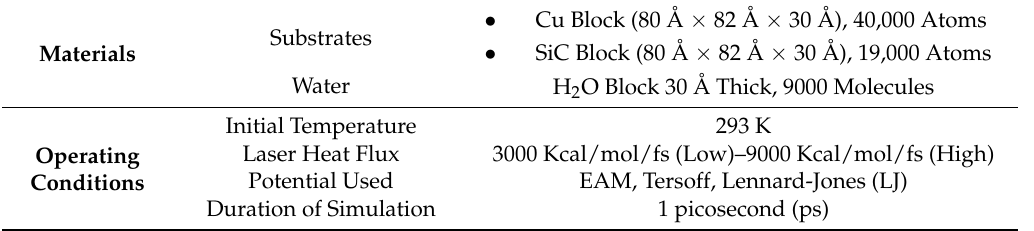
Table 2. Simulation Conditions Used in the MD Simulation of LBMM and LA-LBMM Process.